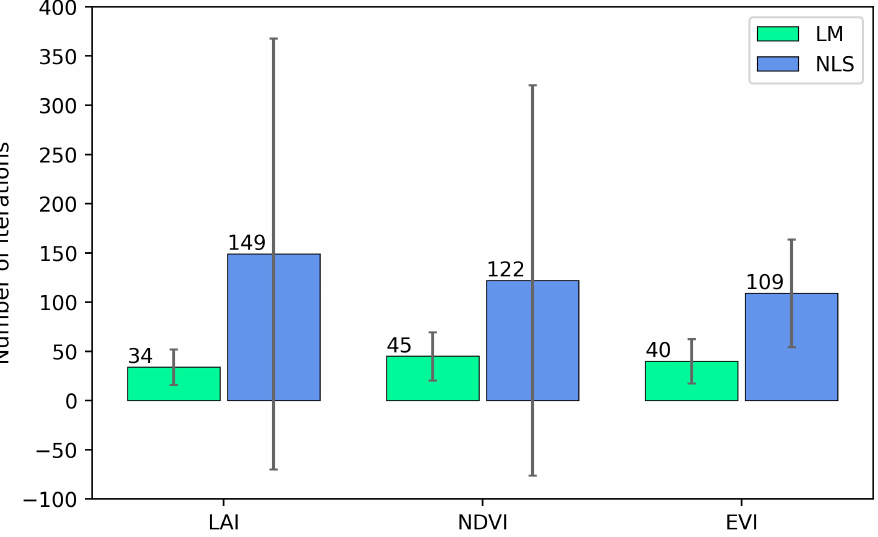
Figure 1. The average number of iterations and its spatial variation in fitting a double-logistic model using the LM and NLS